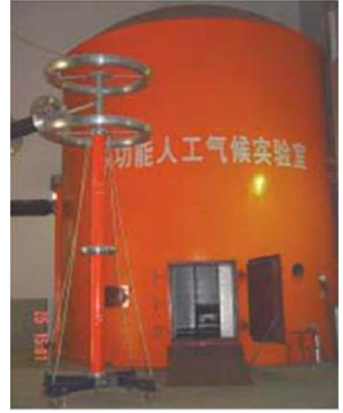
Figure 6. Artificial climate laboratory.